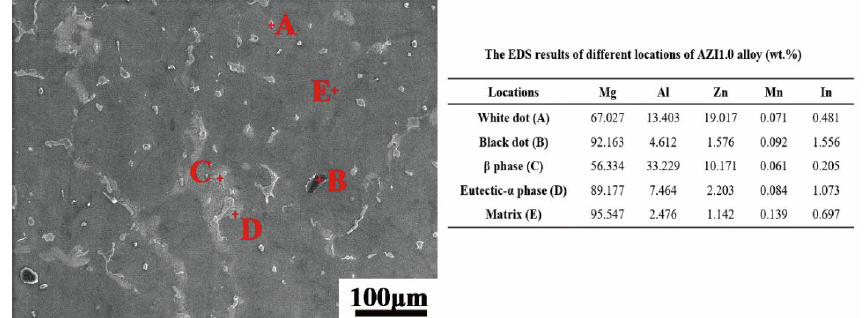
Figure 3. A scanning electron microscopy (SEM) image of AZI1.0 alloy and the energy-dispersive X- ray spectroscopy (EDS) results of different locations.